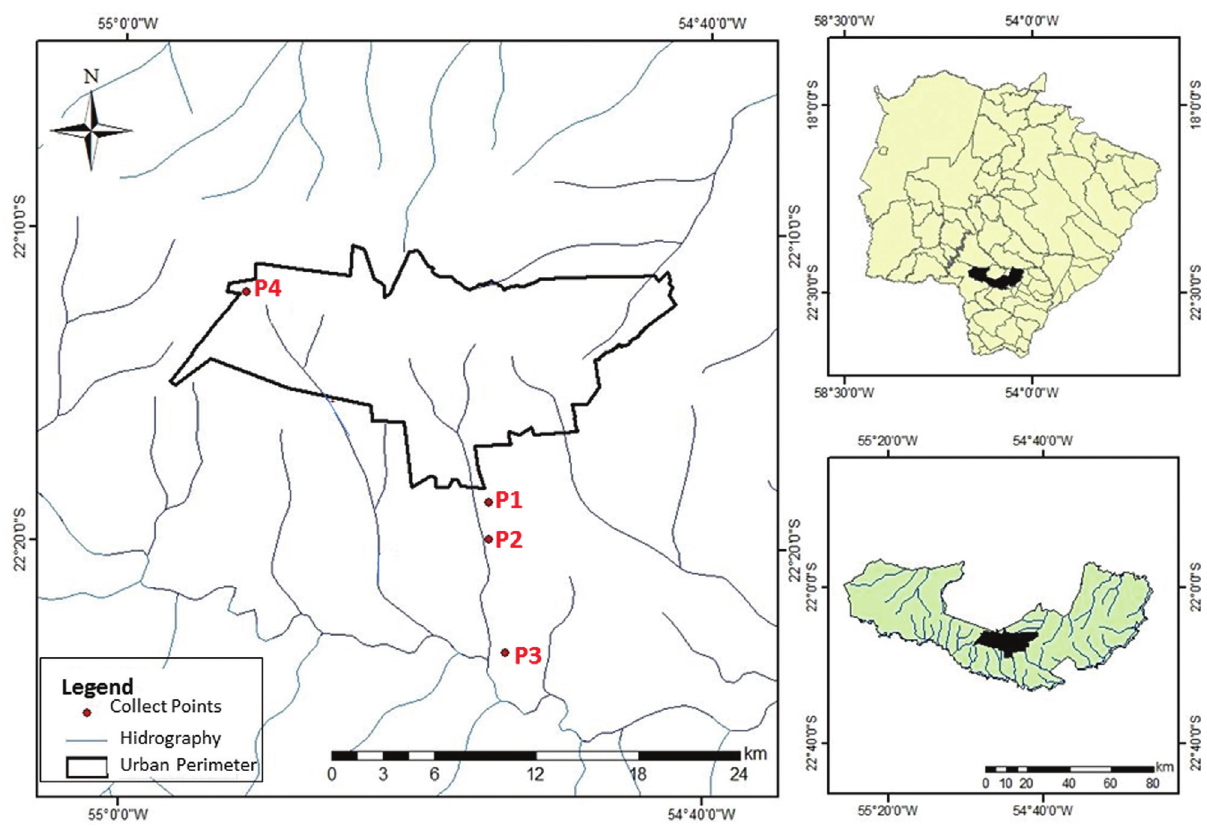
Figure 1 - Collection sites for water samples. Collection points from surface water in the Água Boa stream (P1, P2, P3), and groundwater from artesian well of UFGD